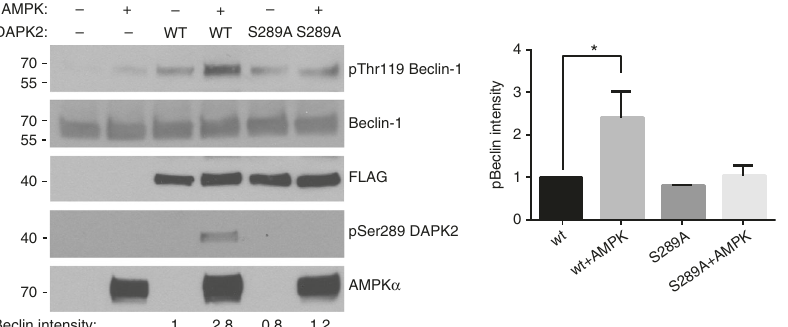
Fig. 7 Ser289 phosphorylation enhances DAPK2 ’ s ability to phosphorylate Beclin-1. Sequential kinase assays of AMPK on FLAG-DAPK2 in AMPK kinase buffer, and then of DAPK2 on Beclin-1 in DAPK2 kinase assay buffer. Phosphorylation was assessed by western blotting of the reaction mixtures. Bar graph represents pBeclin-1 intensity as mean ± SD of two independent repeats. Statistical analyses were performed using one-way ANOVA with post hoc Dunnett ’ s multiple comparison test. * P <